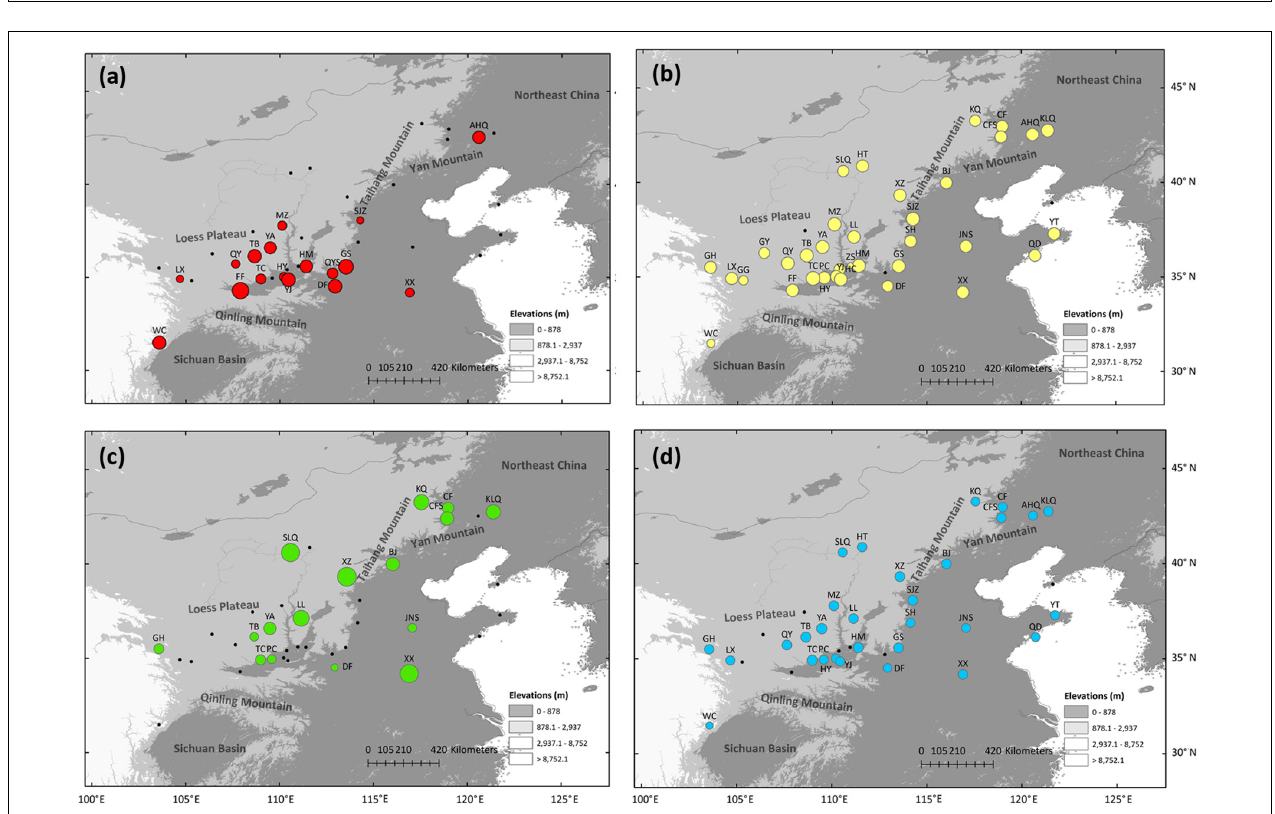
FIGURE 2 | Genetic diversity estimated via haplotype diversity ( H d ) of chloroplast DNA (a) , expected heterozygosity ( H E , b ), private allelic richness ( P AR , c ), and allelic richness ( R S , d ) of nuclear microsatellites of Speranskia tuberculata . Black dots indicate populations with zero or non-calculated genetic diversity.